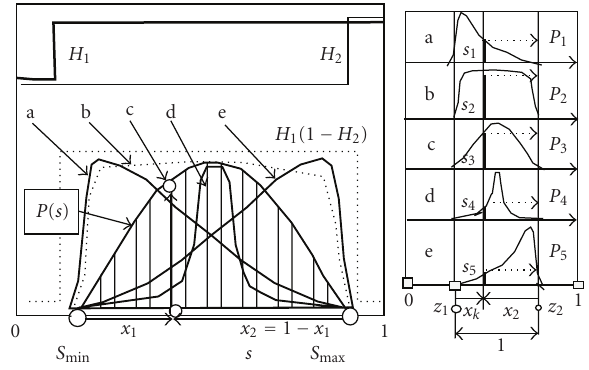
Figure 5: Principle of modelling of the general satisfaction func- tions. Its position and skewness can be varied. Table 1: Skewness parameter values